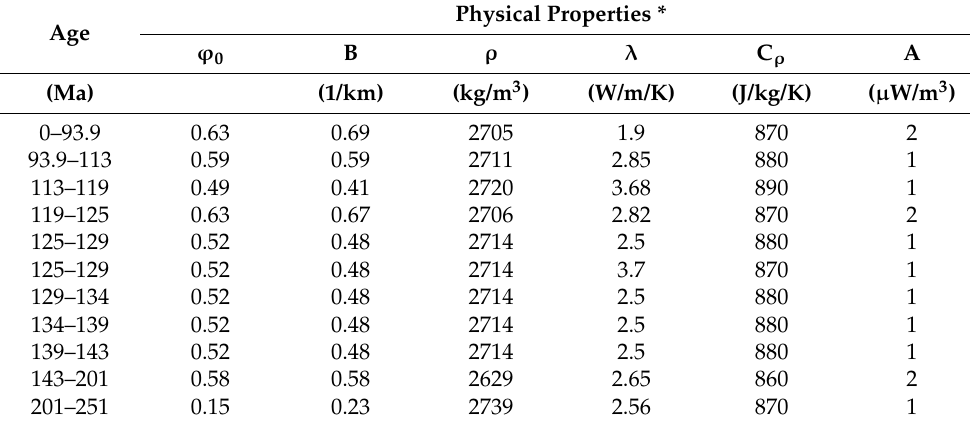
Table A1. Material properties of modelled stratigraphic units (based on